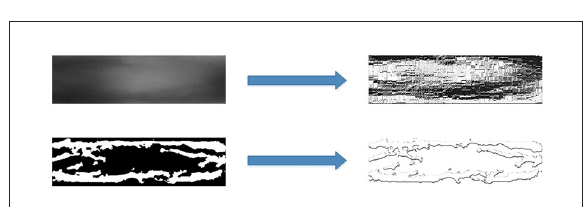
FIGURE3 Segmentation of finger-vein image.